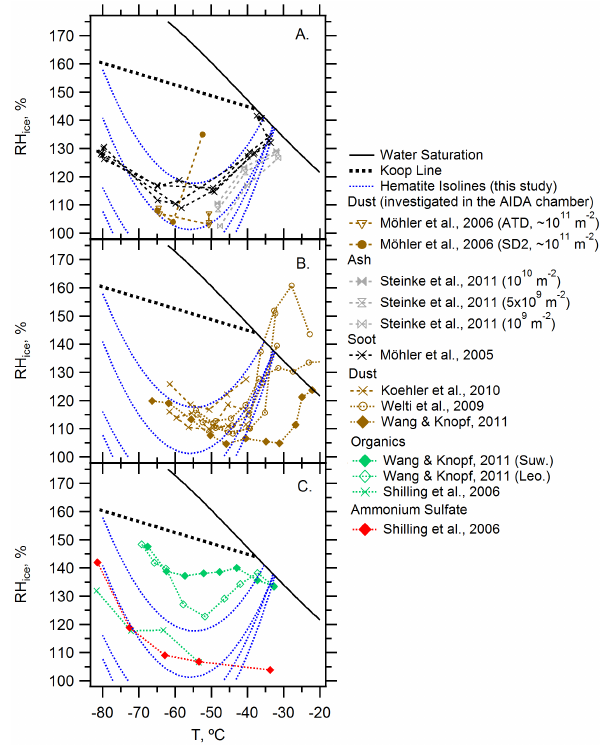
Figure 3. Ice nucleation onset T and RH ice of previously published data ( a AIDA studies, b dust, and c ammonium sulfate and organ- ics) shown together with the isolines of hematite particles from the present study (10 12 m − 2 (top)–10 9 m − 2